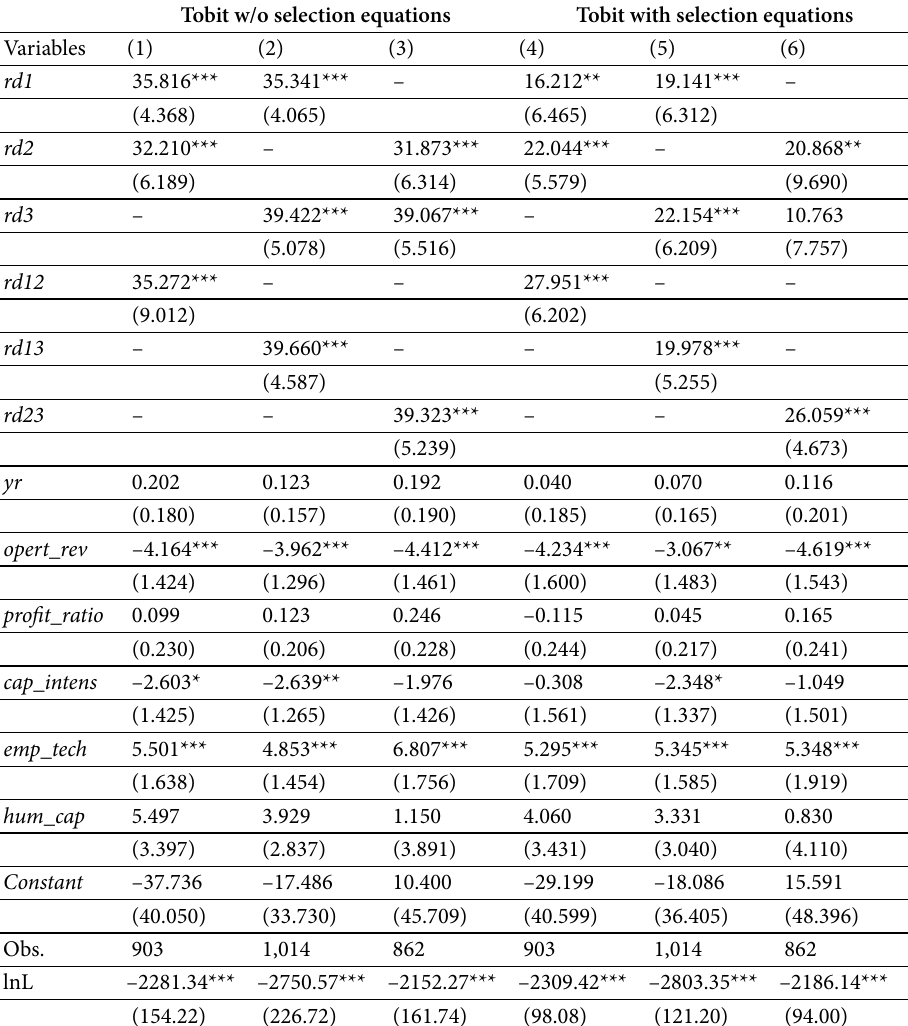
Table 3. Estimation results of innovation output (measured by sales share of new products) Tobit w/o selection equations Tobit with selection